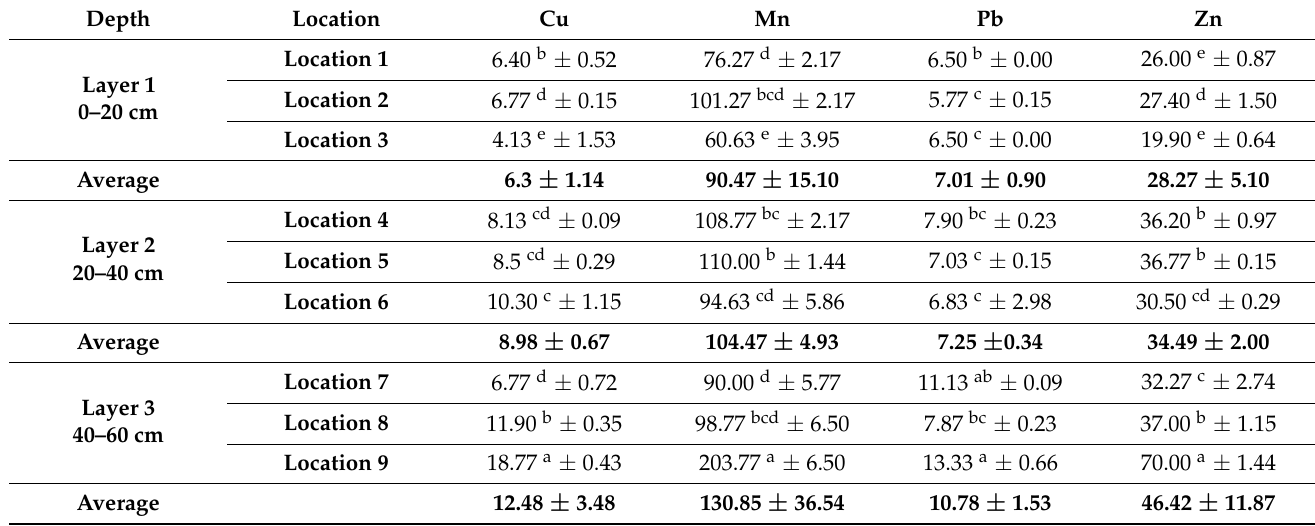
Table 4. HM concentrations * (mean ± SE; mg/kg soil) in different locations within the soil profile under FI at the end of growing season.